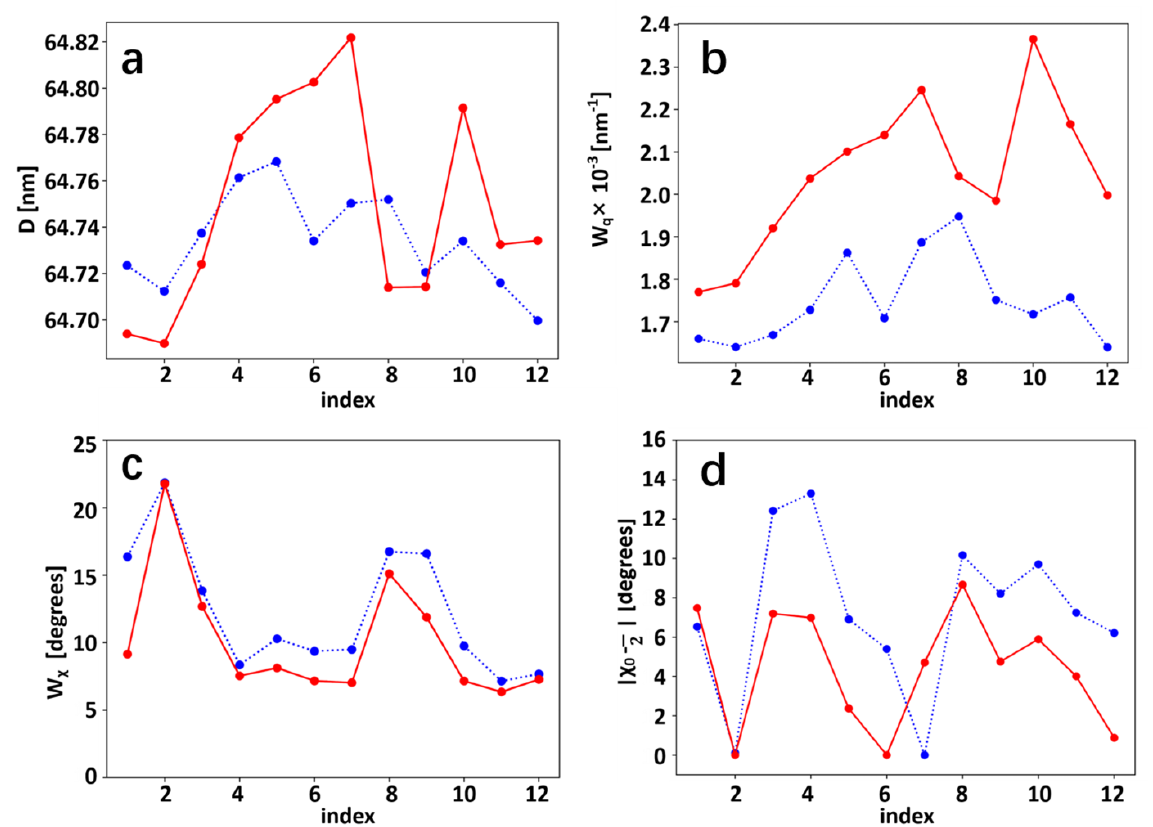
Figure 6. Fibrillar D-period, axial and azimuthal peak widths, and angular position before and after loading: For the selected line-scan (red rectangles) in Figure 5a, line plots of D, w q , w χ and deviation of mean fibril angle χ 0 from π /2 (for all points) are shown before; ( a ) D-period predominantly increases on tension (as expected), but substantial intra-slice variability is seen. ( b ) variability in D-period (w q ), showing a consistent increase; ( c ) consistent but limited decrease in width of fibril angular distribution w χ on tension, and ( d ) nearly consistent alignment of fibrils towards the loading axis. *, **, § and §§ denote same subset of points whose intensity profiles are shown in Figure 5.